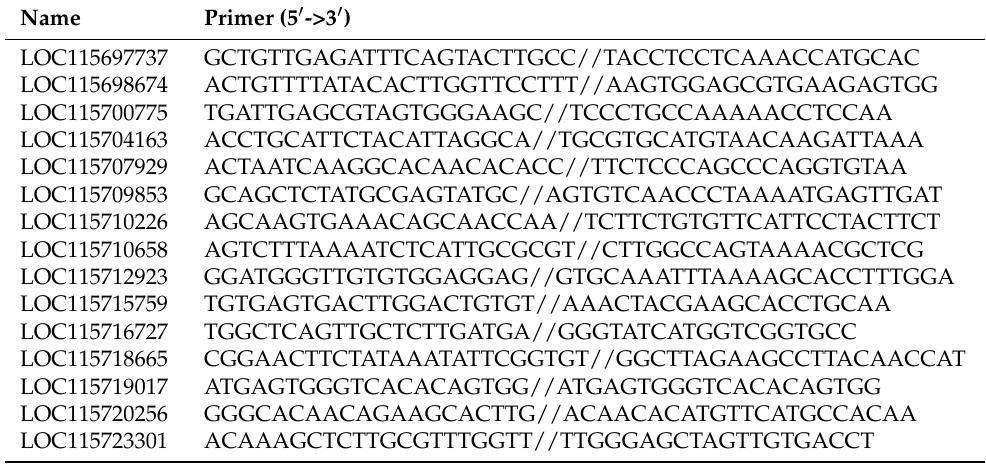
Table 1. Primer sequences of DEGs for